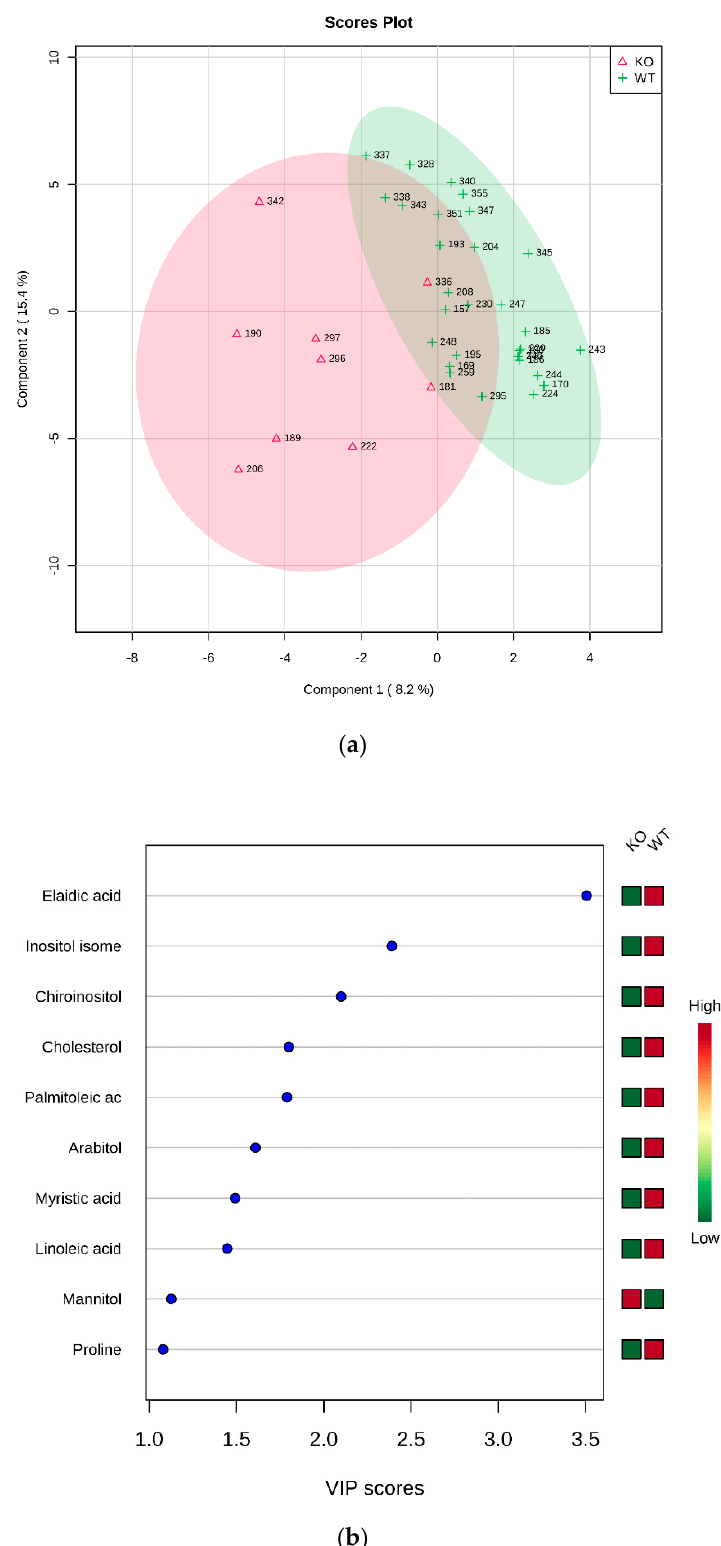
Figure 2. PLS-DA analysis of WT vs. KO. ( a ) 2D scores plot, and ( b ) the corresponding VIP score plot (score > 1.0).